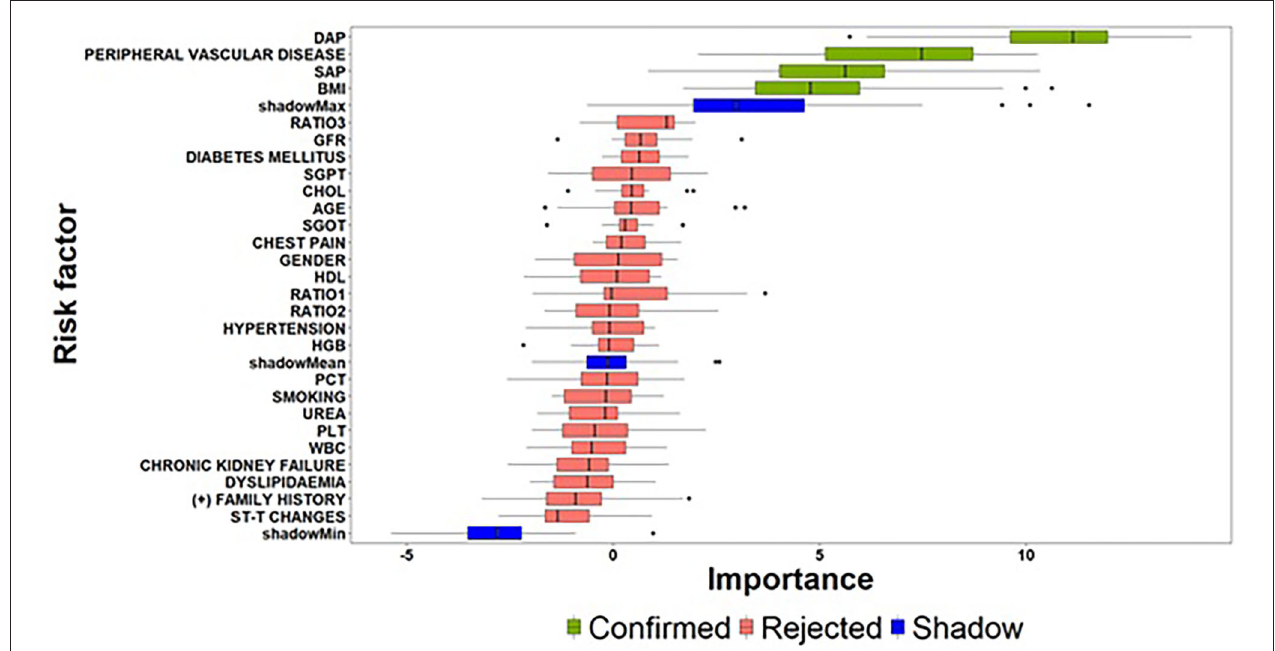
FIGURE 4 | Importance of features extracted by the Boruta algorithm (count-part) (the abbreviations of the risk-factors can be found in Table 4